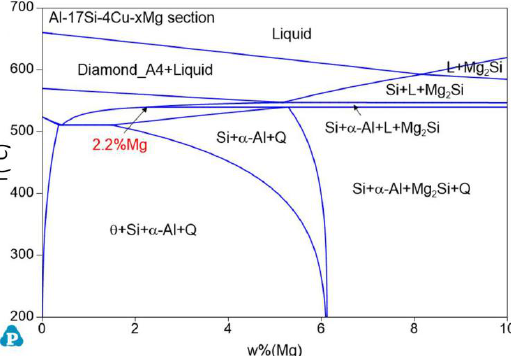
Figure 1. Equilibrium phase diagram for the Al − 17Si − 4Cu − xMg alloys calculated using Pandat software.